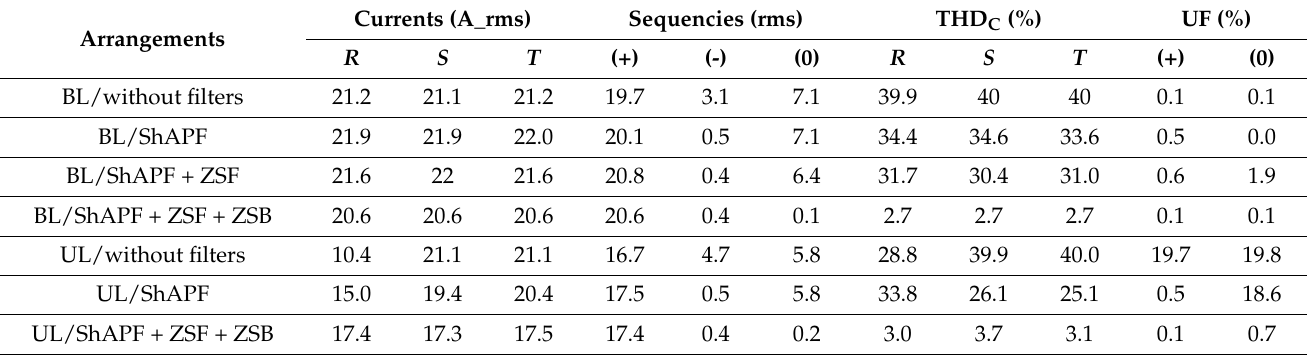
Table 2. Results for different combinations of the hybrid filter arrangement.